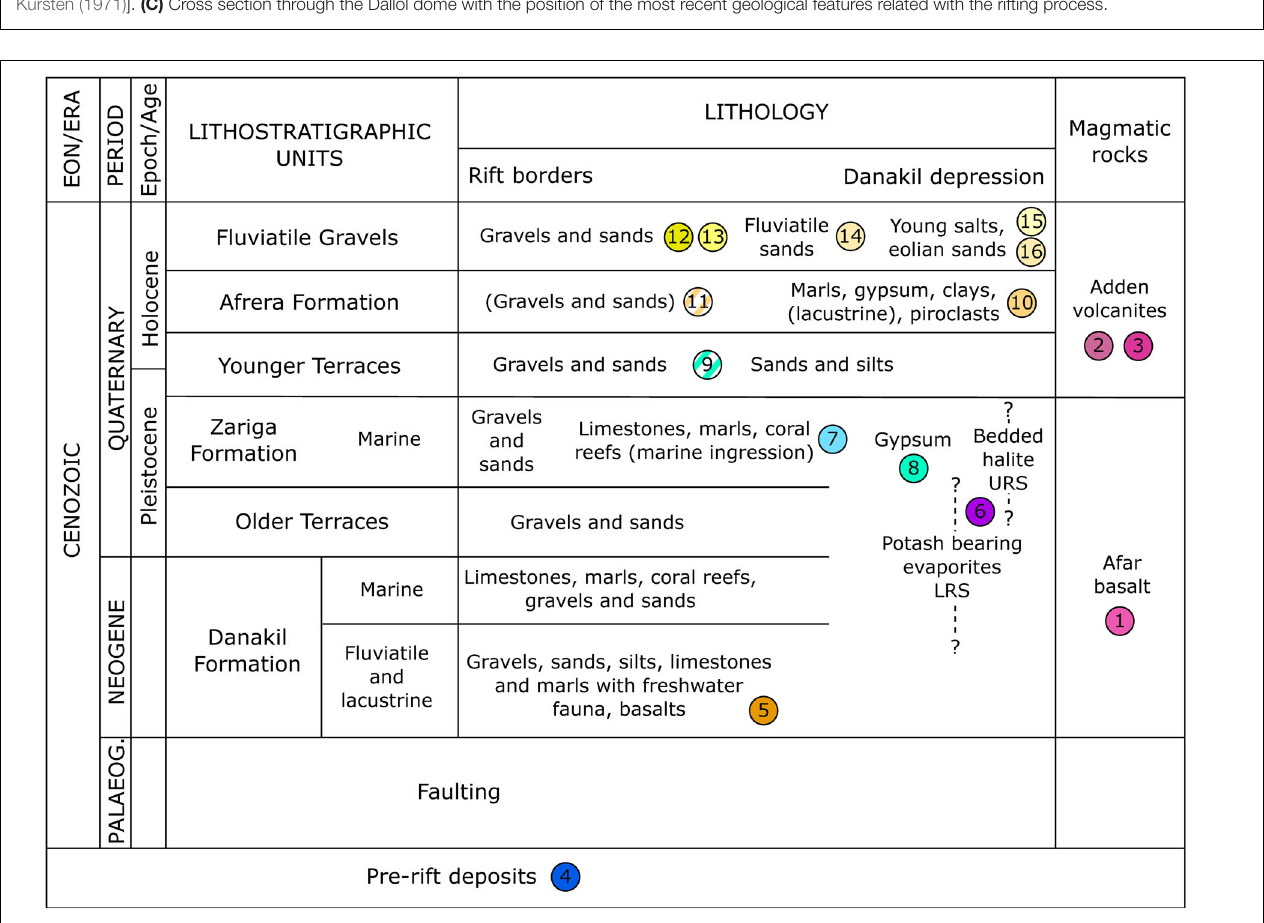
FIGURE 1 | Location and geological map of the Dallol area. (A) Location of the Afar triangle between the Red Sea, Gulf of Aden, and the Main Ethiopian Rift (left). Main geographical and geological features around the studied area of Dallol in the north Afar Danakil depression, below sea level (right). Red triangles correspond to main volcanoes of the Erta Ale ridge (south of Dallol) and Alid region (north of Dallol). Arrows show backrotation of the western side of the Danakil block: 10 ◦ around Nubian-Danakil pole (red star) and 25 ◦ around a secondary pole (purple star) (Reilinger and McClusky, 2011). (B) Geological map [modified after Brinckmann and Kürsten (1971)]. (C) Cross section through the Dallol dome with the position of the most recent geological features related with the rifting process.